Question: Name the type of graph shown.
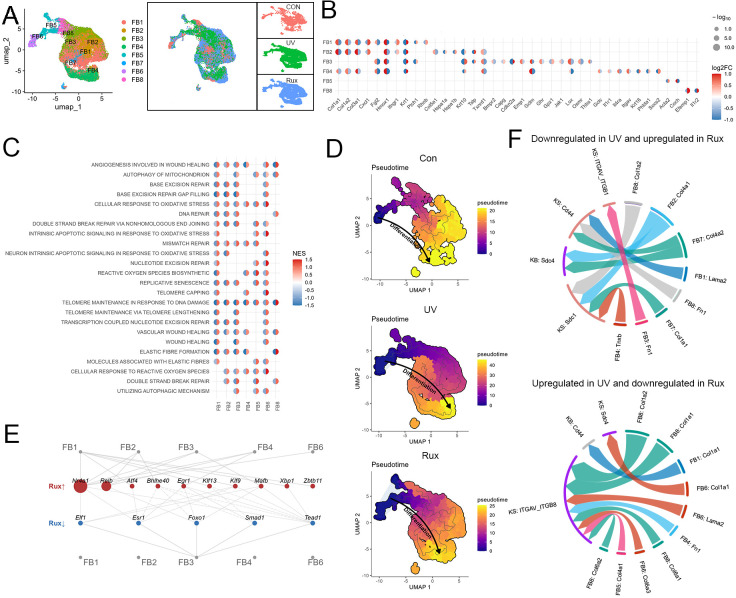
Answer: scatter